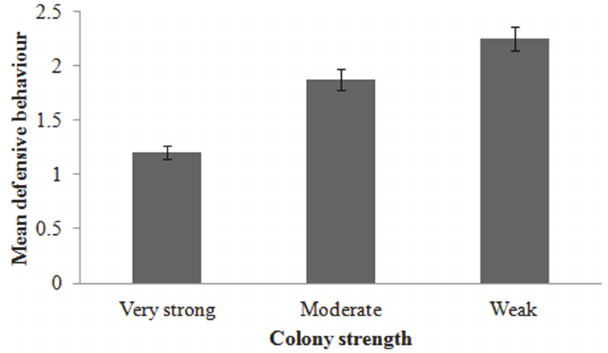
Figure 3: Comparison of the defensive behaviour of the honeybees with the colony strength in the AEZs of Uganda. The defensive behaviour was scored as 1 = very defensive; 2 = moderate; and 3 = less defensive.